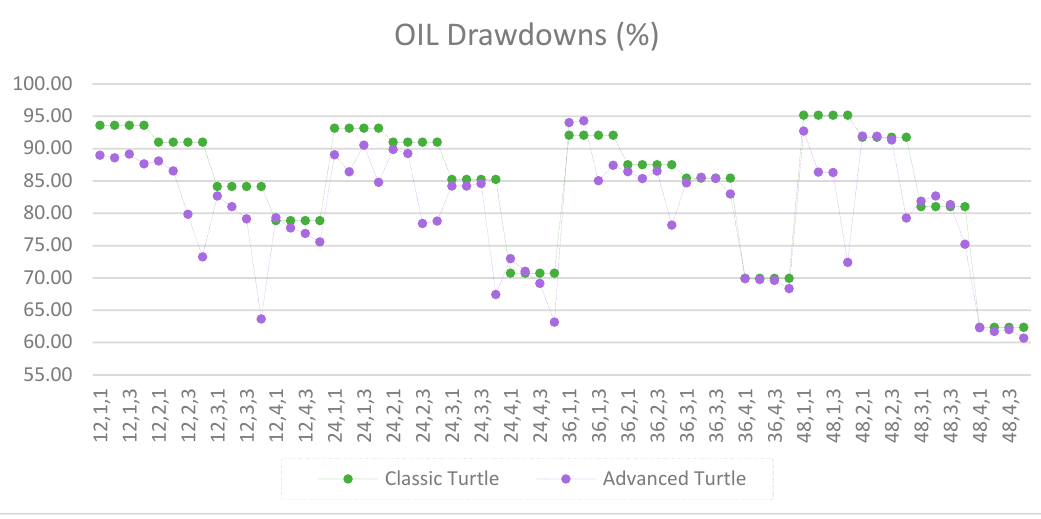
Figure A30. Drawdowns of OIL as percentage of equity between the classic and the advanced Turtle systems for every combination of N, X, Y for the medium parameters (40, 80).